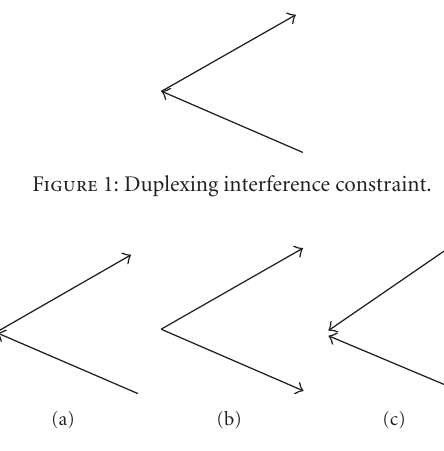
Figure 2: Primary interference constraint.